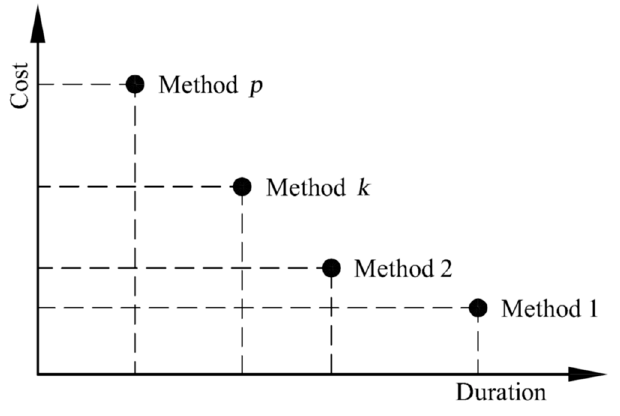
Figure 2. A typical relationship between time and cost of an activity [63].